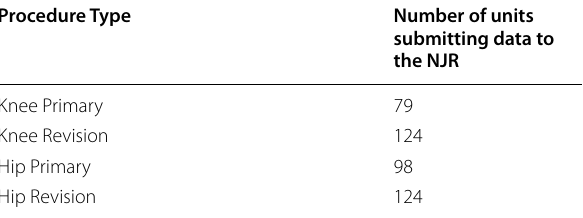
Table 2 Number of individual units submitting data